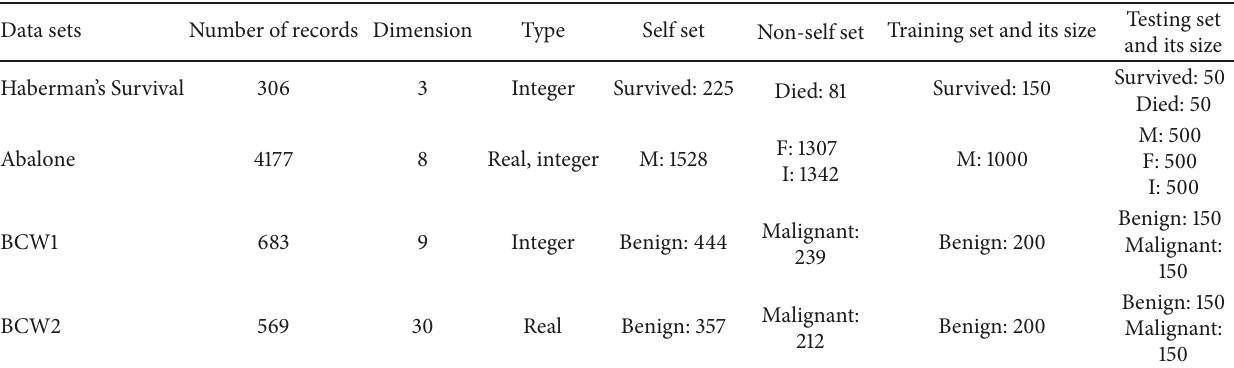
Figure 16: Comparisons of the number of detectors of RNSA, V-Detector, and CB-RNSA. Table 4: Experimental